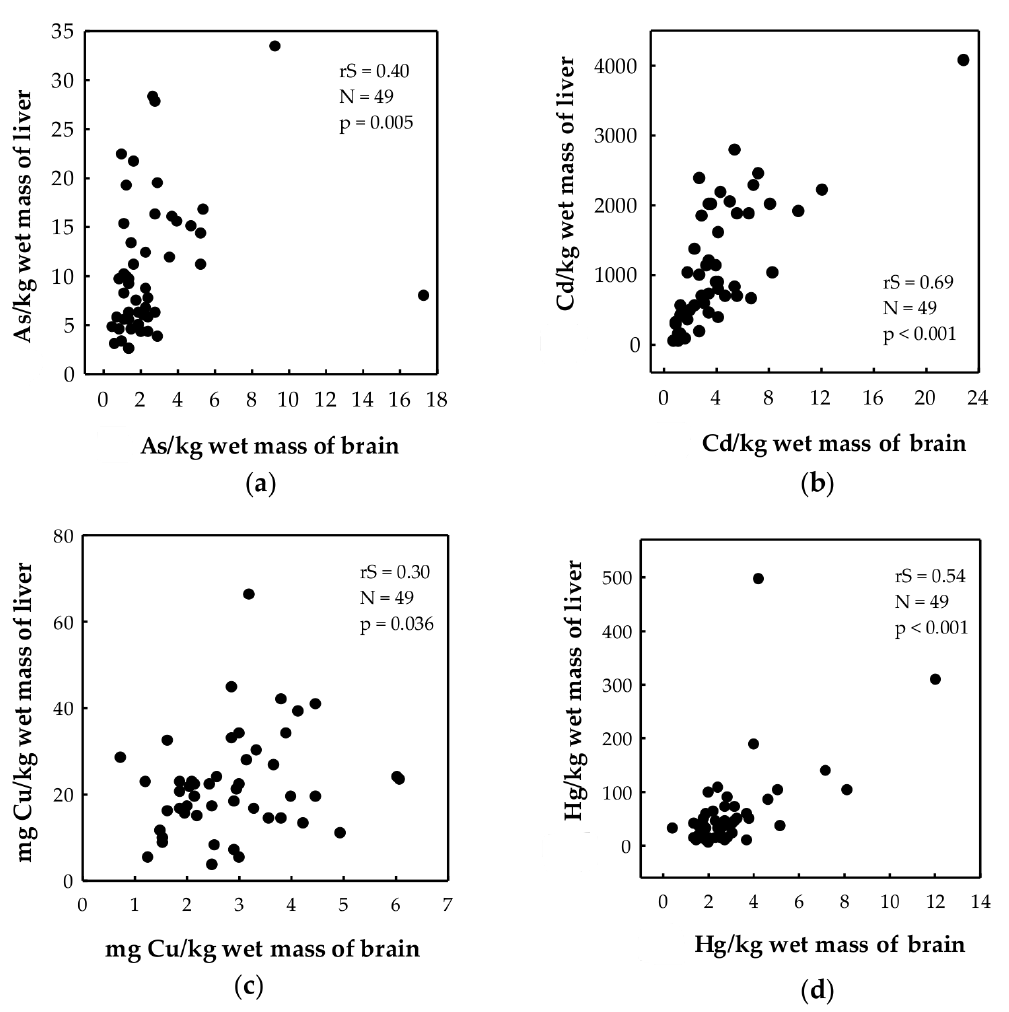
Figure 2. Correlation of ( a ) As; ( b ) Cd; ( c ) Cu; and ( d ) Hg levels between the brain and the liver of brown bears from Croatia. r S —Spearman correlation coefficient; N—number of individuals; p —level of